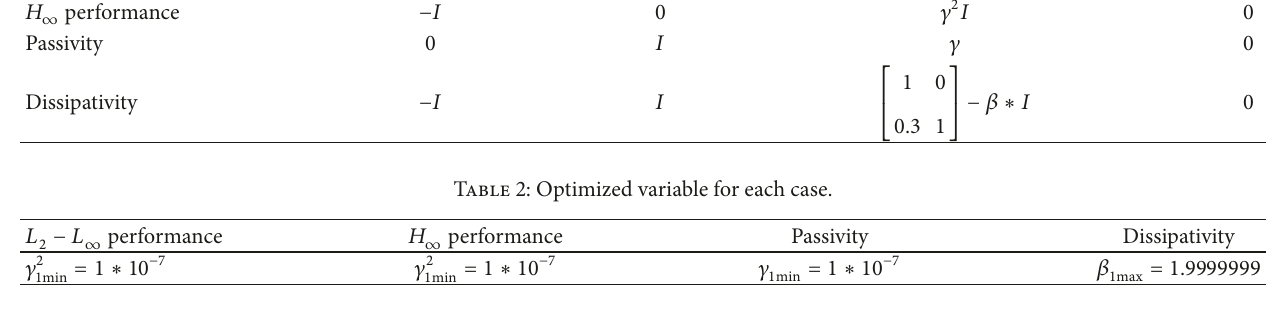
Table 3: Controller gain of the additive form controller uncertainty for each